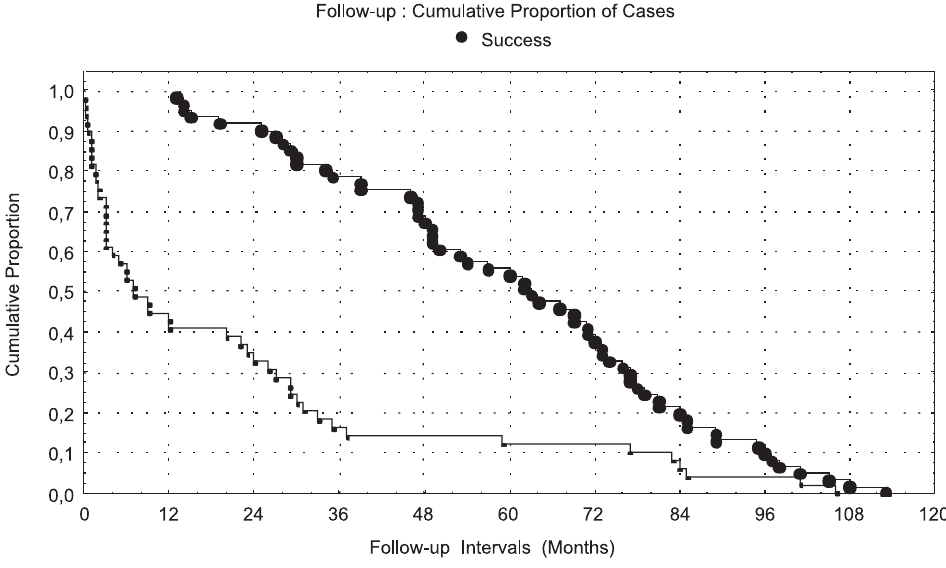
Figure 1 - Cumulative proportion of success Ψ Ψ Number of patients at risk for failure at each time interval: 56 (at 24 months), 48 (at 36 months), 41 (at 48 months), 33 (at 60 months), 23 (at 72 months), 12 (at 84 months), 6 (at 96 months), 1 (at 108 months) and 0 (at 120